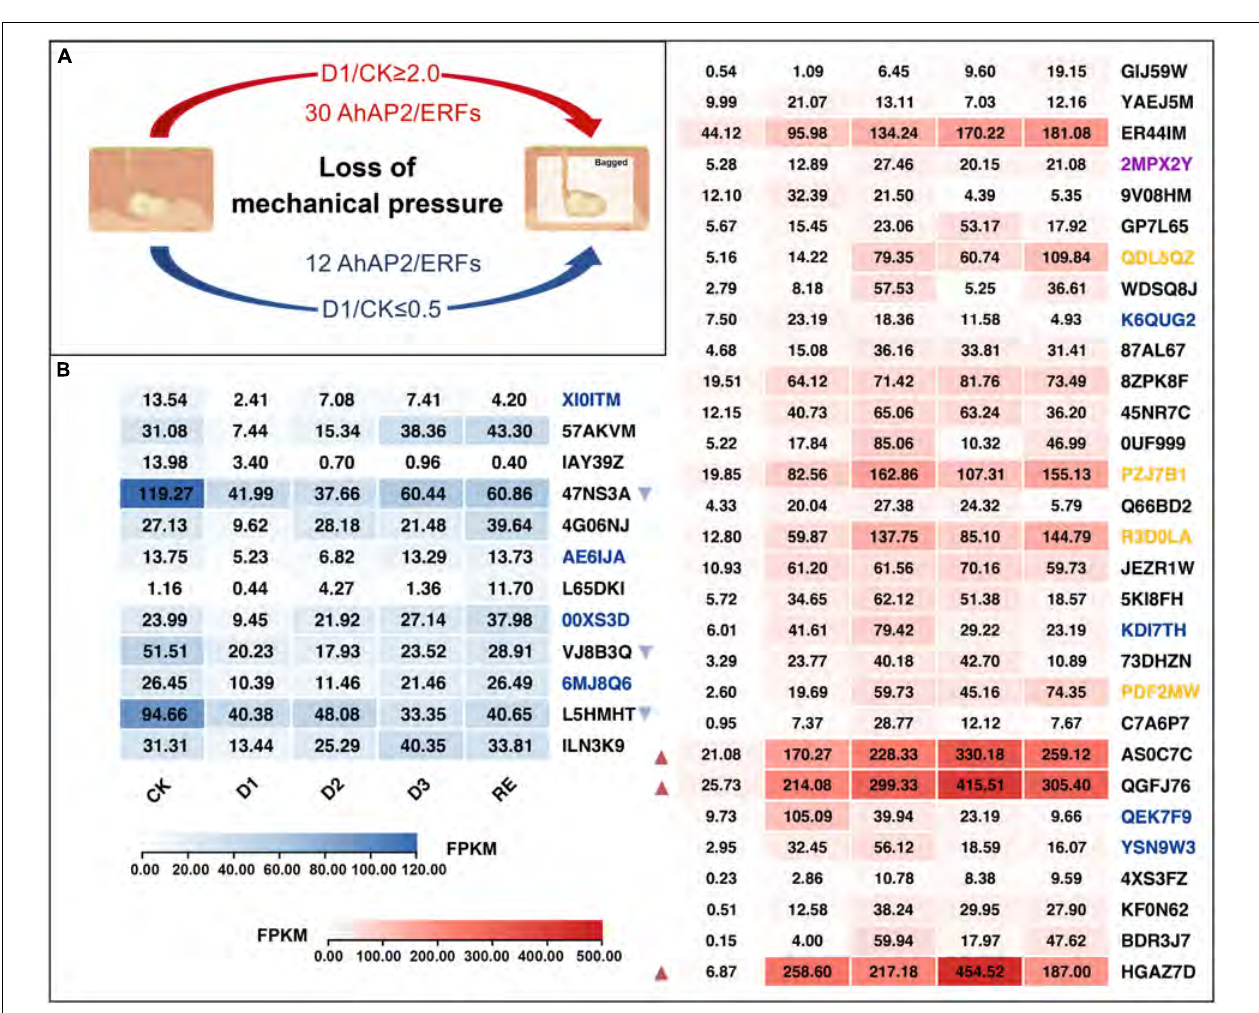
FIGURE 8 | Expression changes of AhAP2/ERF genes in mechanical stress simulation experiment. Black gene ID: ERFs; blue gene ID: AP2; yellow gene ID: RAV; purple gene ID: Soloist. CK: control group, pods just out of the soil; D1: treatment group, 10 h bagging; D2: 34 h bagging; D3: 58 h bagging; RE: pods buried back into the soil for 48 h ( Supplementary Figure 1C : Flowchart). (A) Number of differentially expressed AhAP2/ERF genes after 10 h loss of mechanical stress; (B) The FPKM value of AhAP2/ERF genes. The red and blue triangles indicated genes with high upregulation or downregulation,